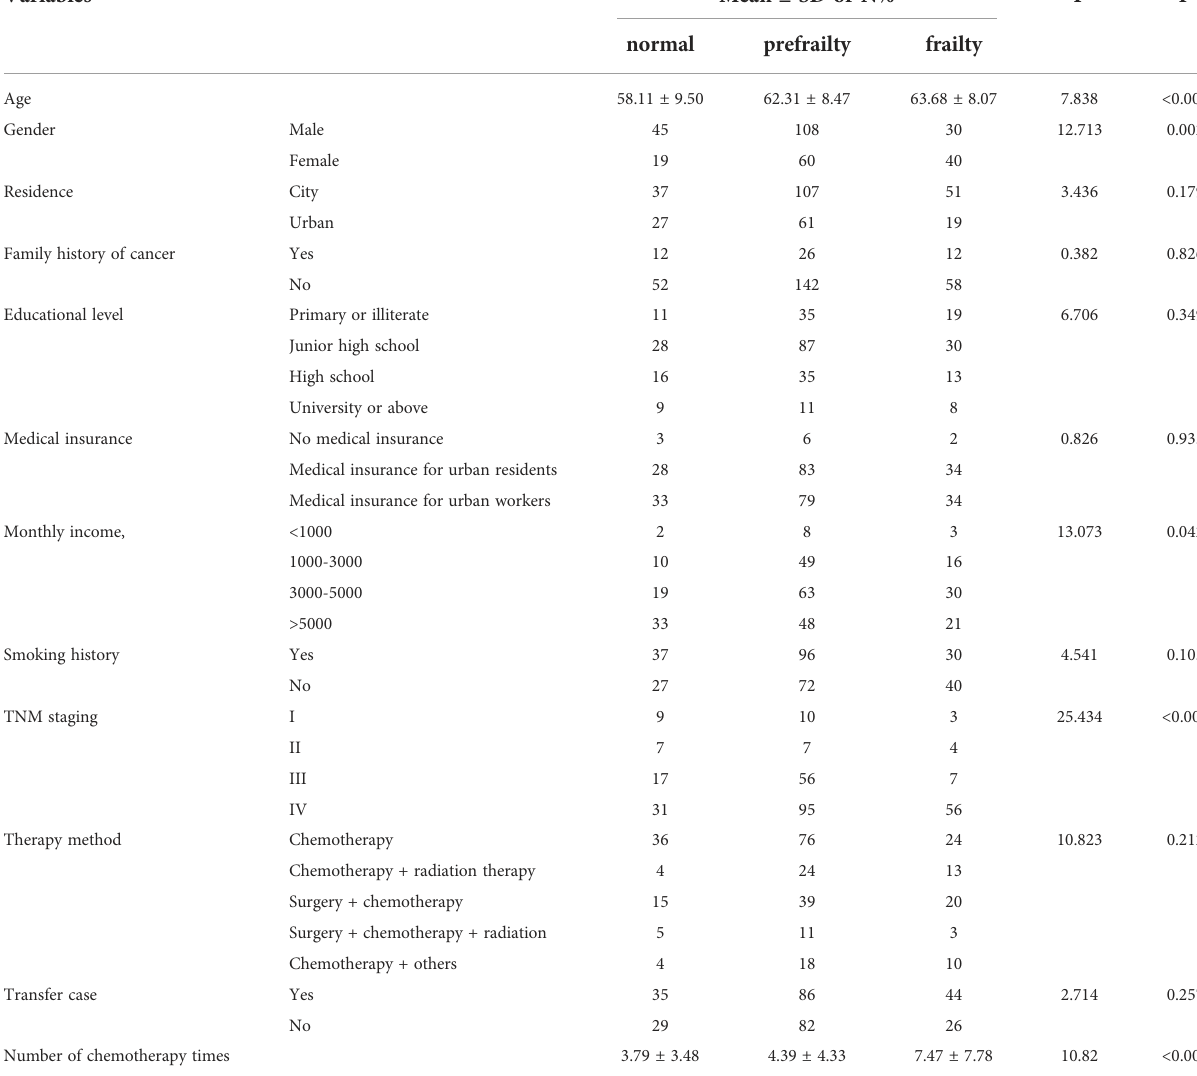
TABLE 2 Frailty status differences among demographic characteristics (N=302).